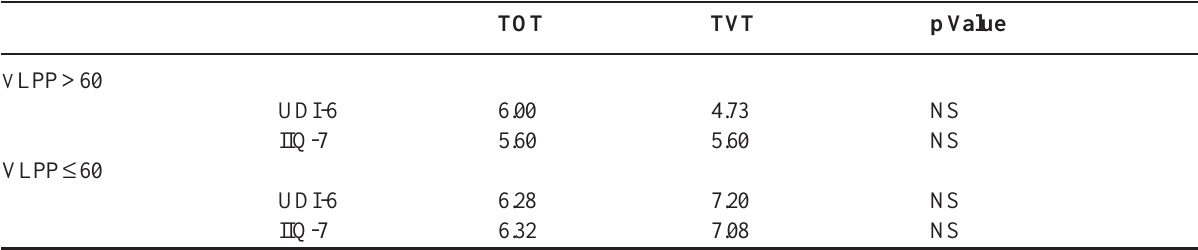
Table 6 – Mean changes of questionnaire values (basal values minus postoperative